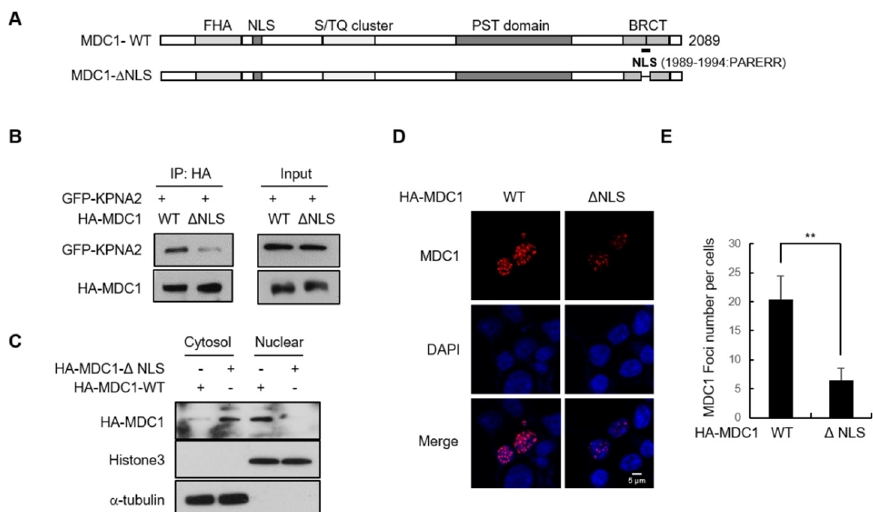
Figure 3. Identification of functional NLS in MDC1. ( A ) A schematic representation of HA-tagged wild-type MDC1 (MDC1-WT) and NLS-deleted HA-MDC1 (MDC1- Δ NLS). Putative nuclear localization signal (NLS, PARERR) is shown. ( B ) GFP-KPNA2 were transfected into HEK293T cells along with HA-MDC1-WT or HA-MDC1- Δ NLS. Whole cell lysates were then subjected to immunoprecipitation using anti-HA antibody, followed by Western blotting using indicated antibodies. ( C ) HeLa cells were transfected with MDC1-WT or MDC1- Δ NLS, and the cytosol and nuclear fractions were isolated. The cytosol and nuclear extracts were subjected to Western blotting using indicated antibodies. ( D,E ) MDC1-WT or MDC1- Δ NLS-transfected HeLa cells were irradiated with IR and the number of IR-induced HA-MDC1 foci was calculated. Representative images ( D ) and quantification ( E ) of HA-MDC1 foci are shown. Scale bar; 5 μ m. Data represent mean ± SD ( n = 3), ** p < 0.01.